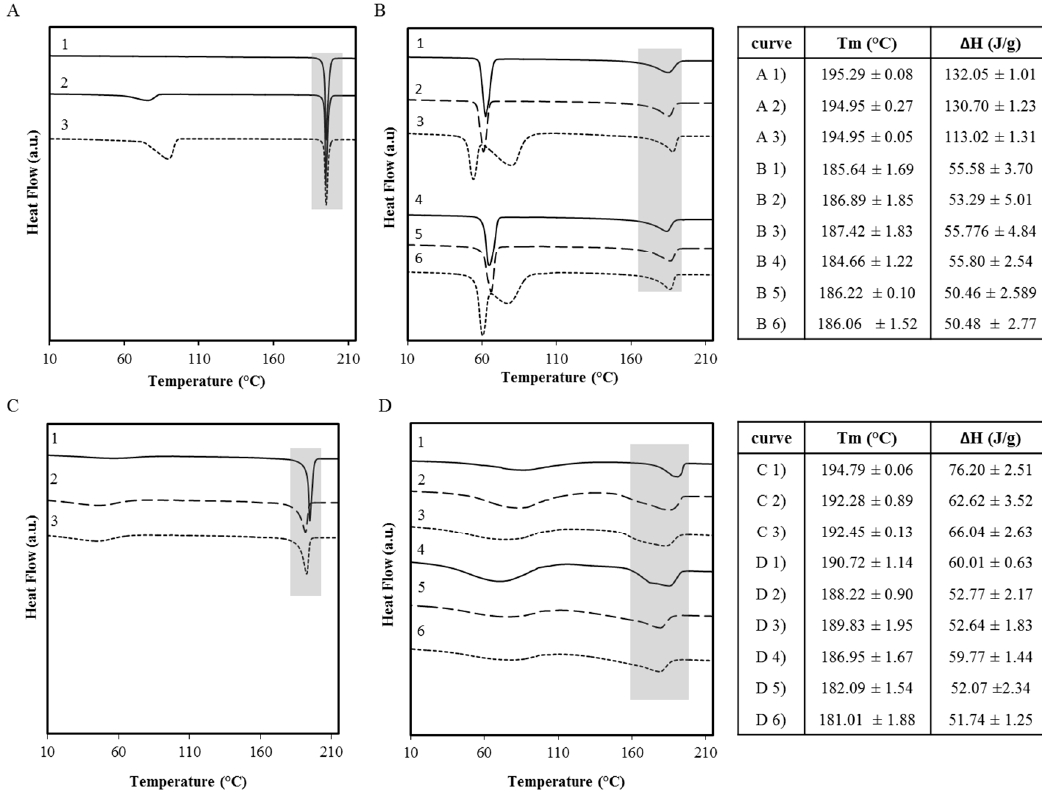
Figure 6. Thermograms of formulations A ( A ); B 1 ( B , curves 1–3; B 2 ( B , 4–6); C ( C ); D 1 ( D , 1–3) and D 2 ( D , 4–6). Curve 1 shows the physical mixture of raw materials, curves 2 and 5 show wet masses at t = 0 min, and curves 3 and 6 show the wet masses at t = 360 min. Tables present the melting point of OLZ and the respective enthalpy of fusion (Tmax and ∆ H) for each formulation (grey shadow in figures).